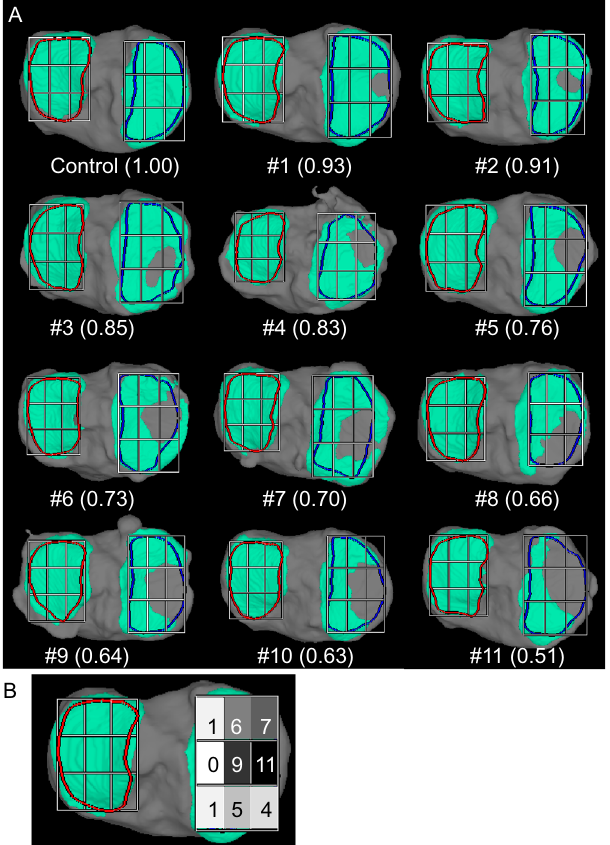
Figure 5. Location of defects in the medial tibial cartilage. ( A ) Cartilage area of the tibia determined by 3D magnetic resonance imaging (MRI). The tibial cartilage is shown in green, and the region of interest (ROI) of the medial tibial cartilage is shown enclosed within the blue line in the fully automated 3D-constructed MRI image. The cartilage area ratio is defined as the ratio of the cartilage area to the ROI area. The cartilage area ratio at the medial tibia is also shown, and the images are ordered from the highest to the lowest ratios. The ROI of the medial tibial cartilage was divided into 9 subregions, with 3 equal vertical and 3 equal horizontal lines. ( B ) Number of knees with cartilage defects in each subregion among 11 knees. The thickness of the cartilage is indicated by color mapping, where white indicates a thickness ≥ 2 mm and the progression from yellow to red indicates thinning of the cartilage. The tibia bone is shown in